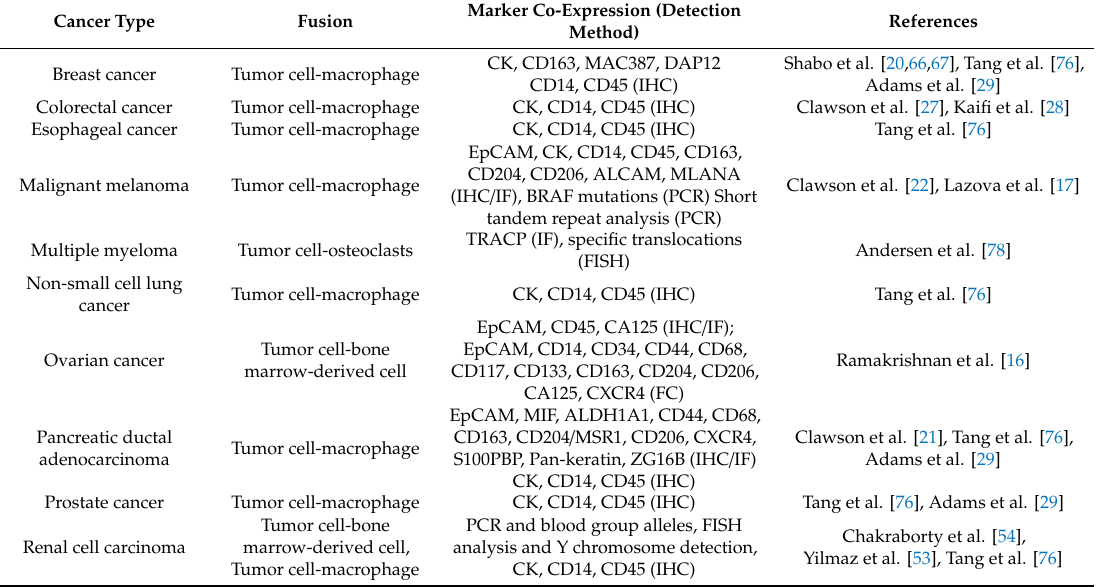
Table 2. Detection of fusion cells in human